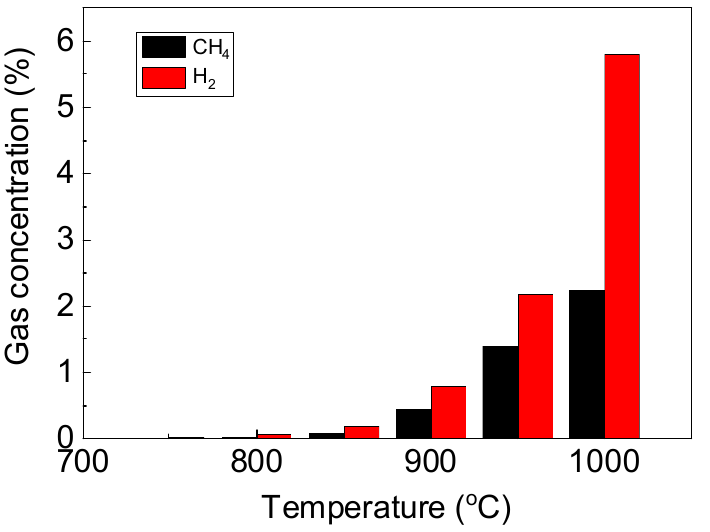
Figure 3. Gas concentration during thermal toluene pyrolysis at typical temperature without bed material.